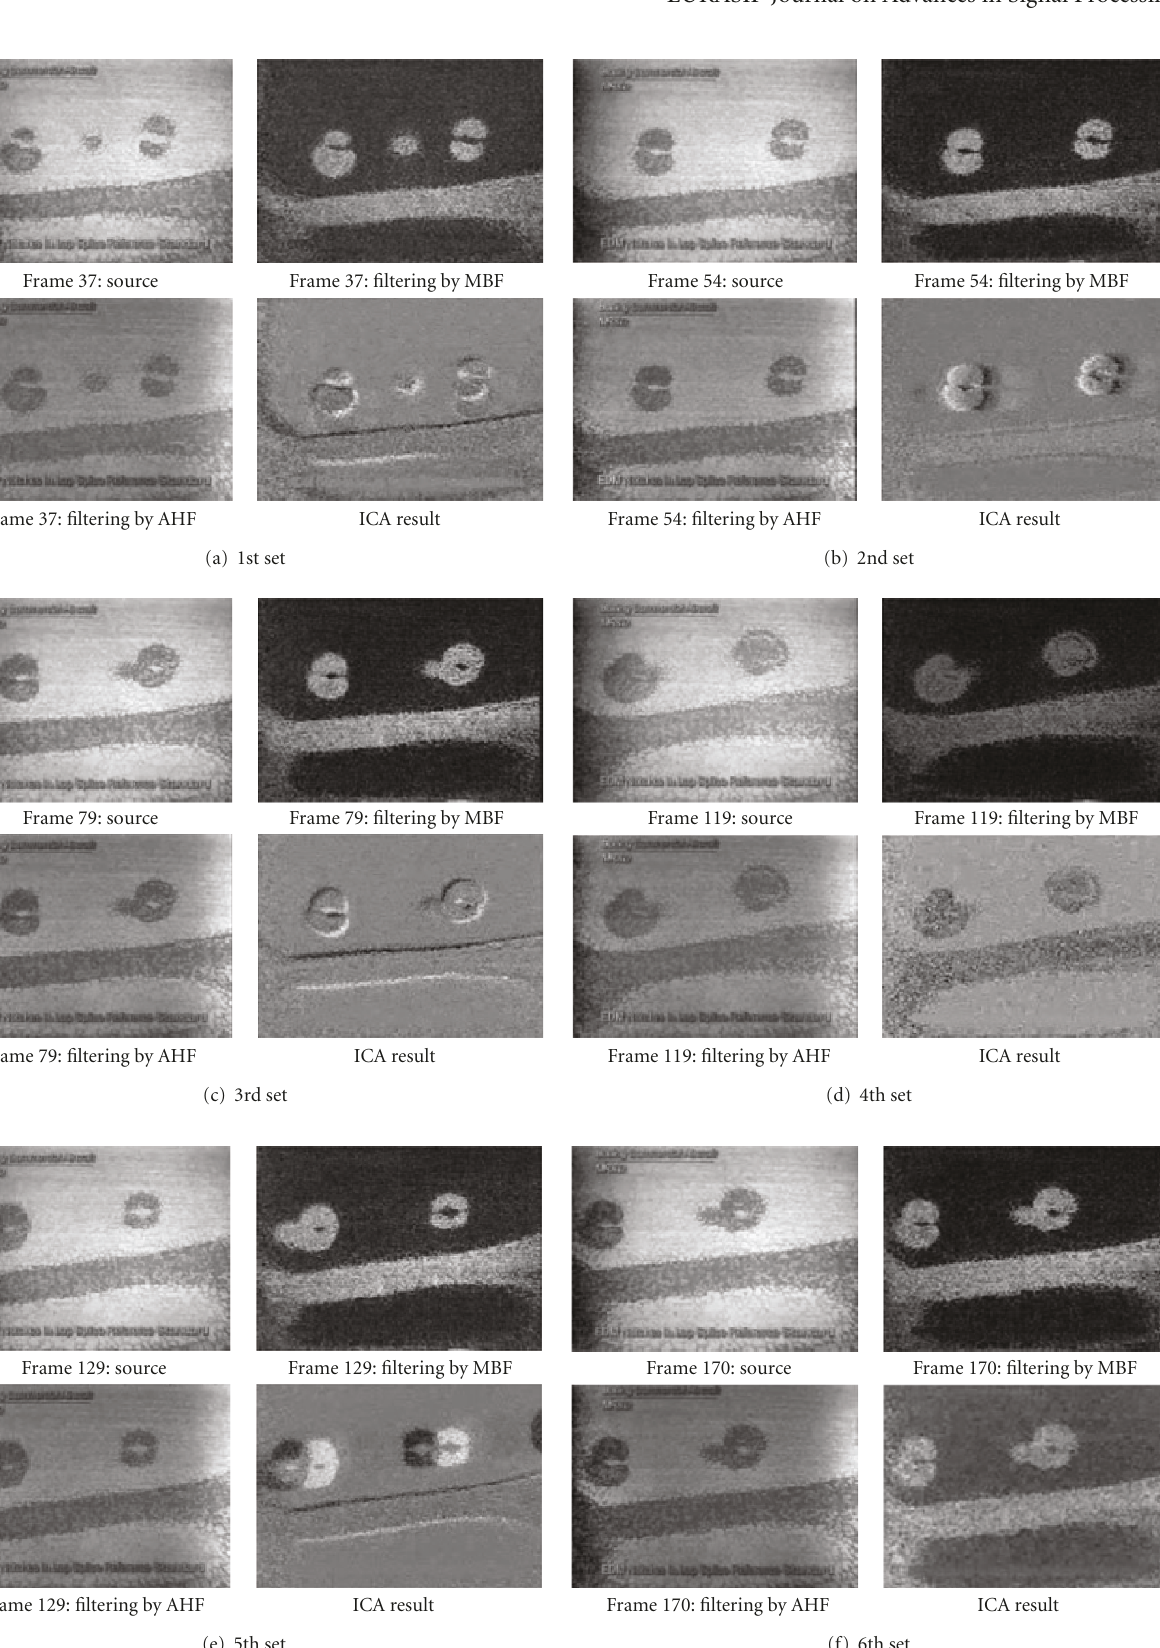
Figure 9: Comparison of the performance for MBF, AHF, and